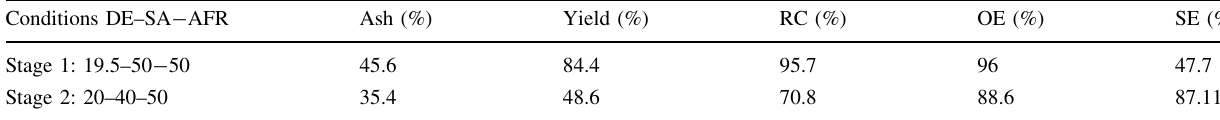
Table 7 Separation performance in two stages Conditions DE–SA - AFR